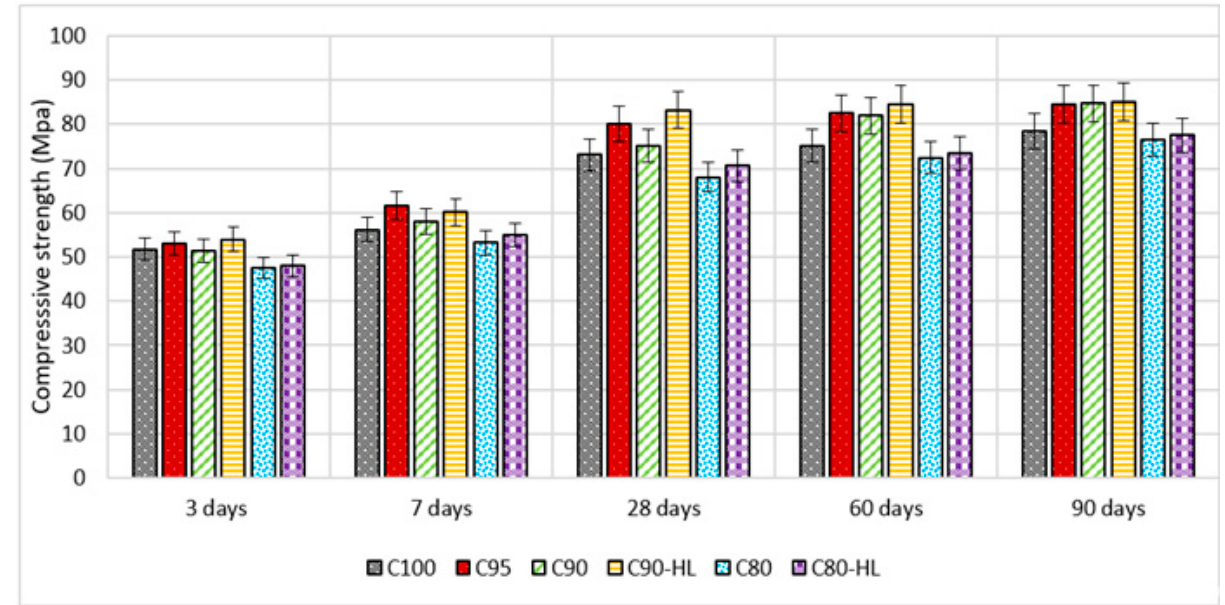
Figure 11. Self-compacting paste formulations’ compressive strength at various replacement percentages.